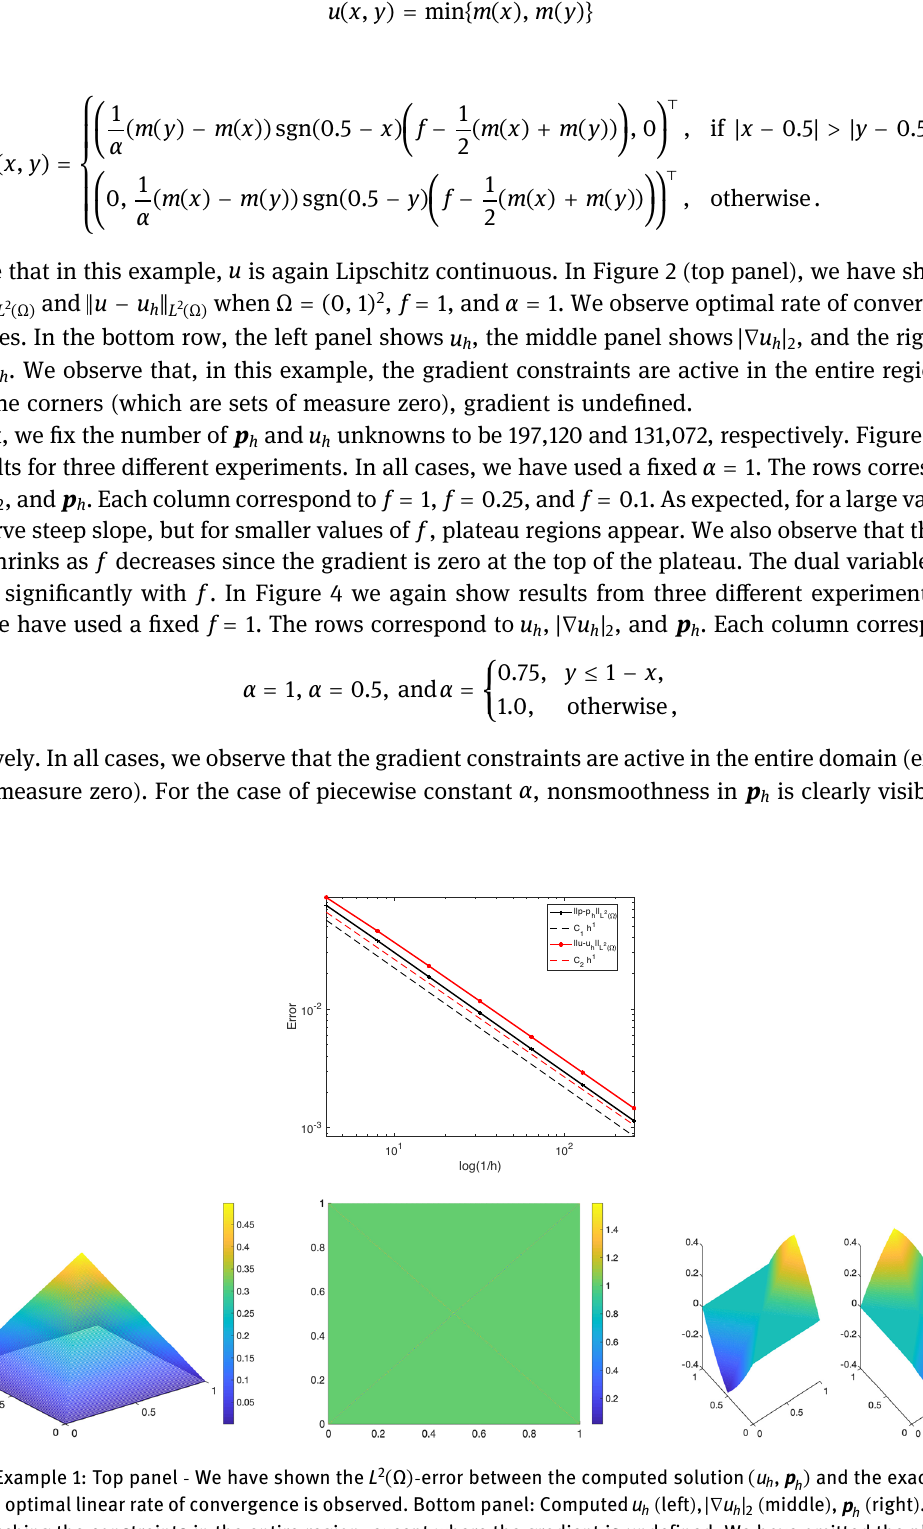
Figure 2: Example 1: Top panel - We have shown the ( ) L Ω 2 - error between the computed solution ( ) p u , h ( ) p u , . The optimal linear rate of convergence is observed. Bottom panel: Computed u h ( left ) , ∣ ∣ u h 2 ∇ ( middle ) , p